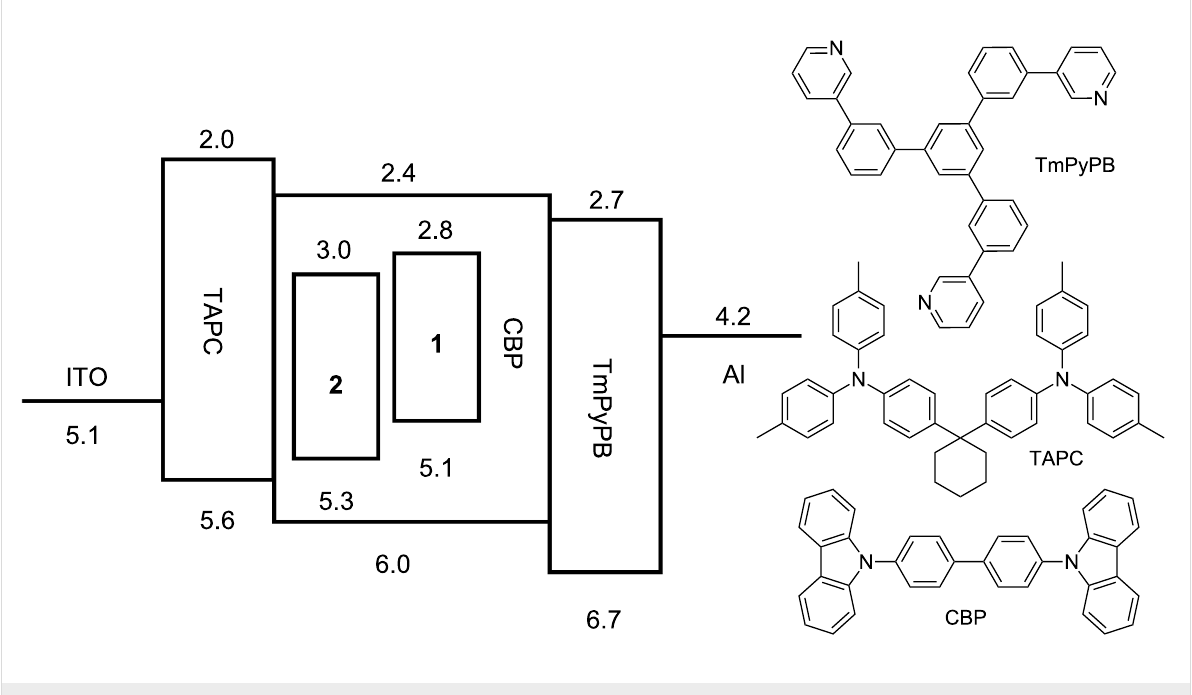
Figure 5: Energy level (eV) diagrams of OLED devices and the chemical structures of the materials utilized for device fabrication.